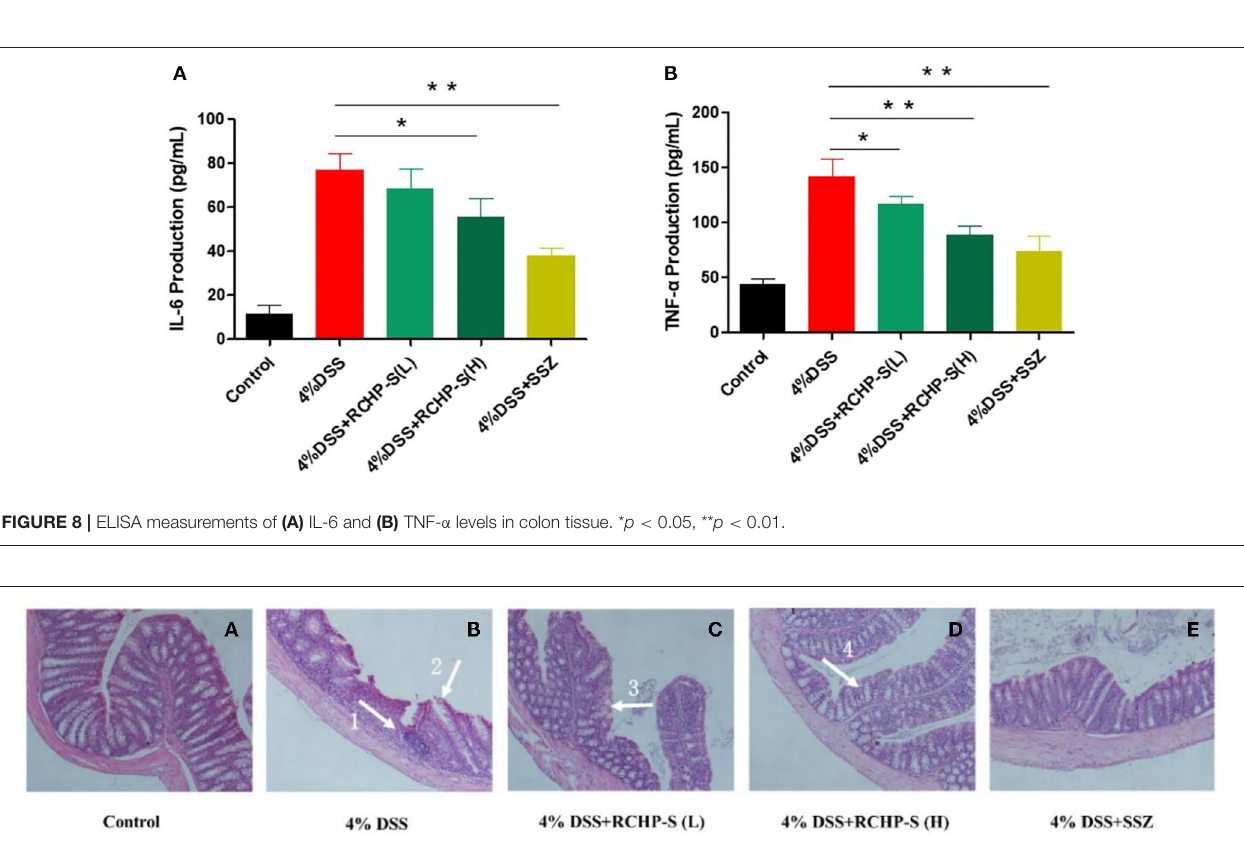
FIGURE 9 | Haematoxylin-eosin (HE) staining of colon among the different groups (200 × ). (A) Control. (B) 4% DSS. (C) 4% DSS + RCHP-S (L). (D) 4% DSS + RCHP-S (H). (E) 4% DSS + SSZ (arrow 1 indicates the accumulation of inflammatory cells; arrow 2 and 3 indicate the loss of crypts; arrow 4 indicates the intact crypts).